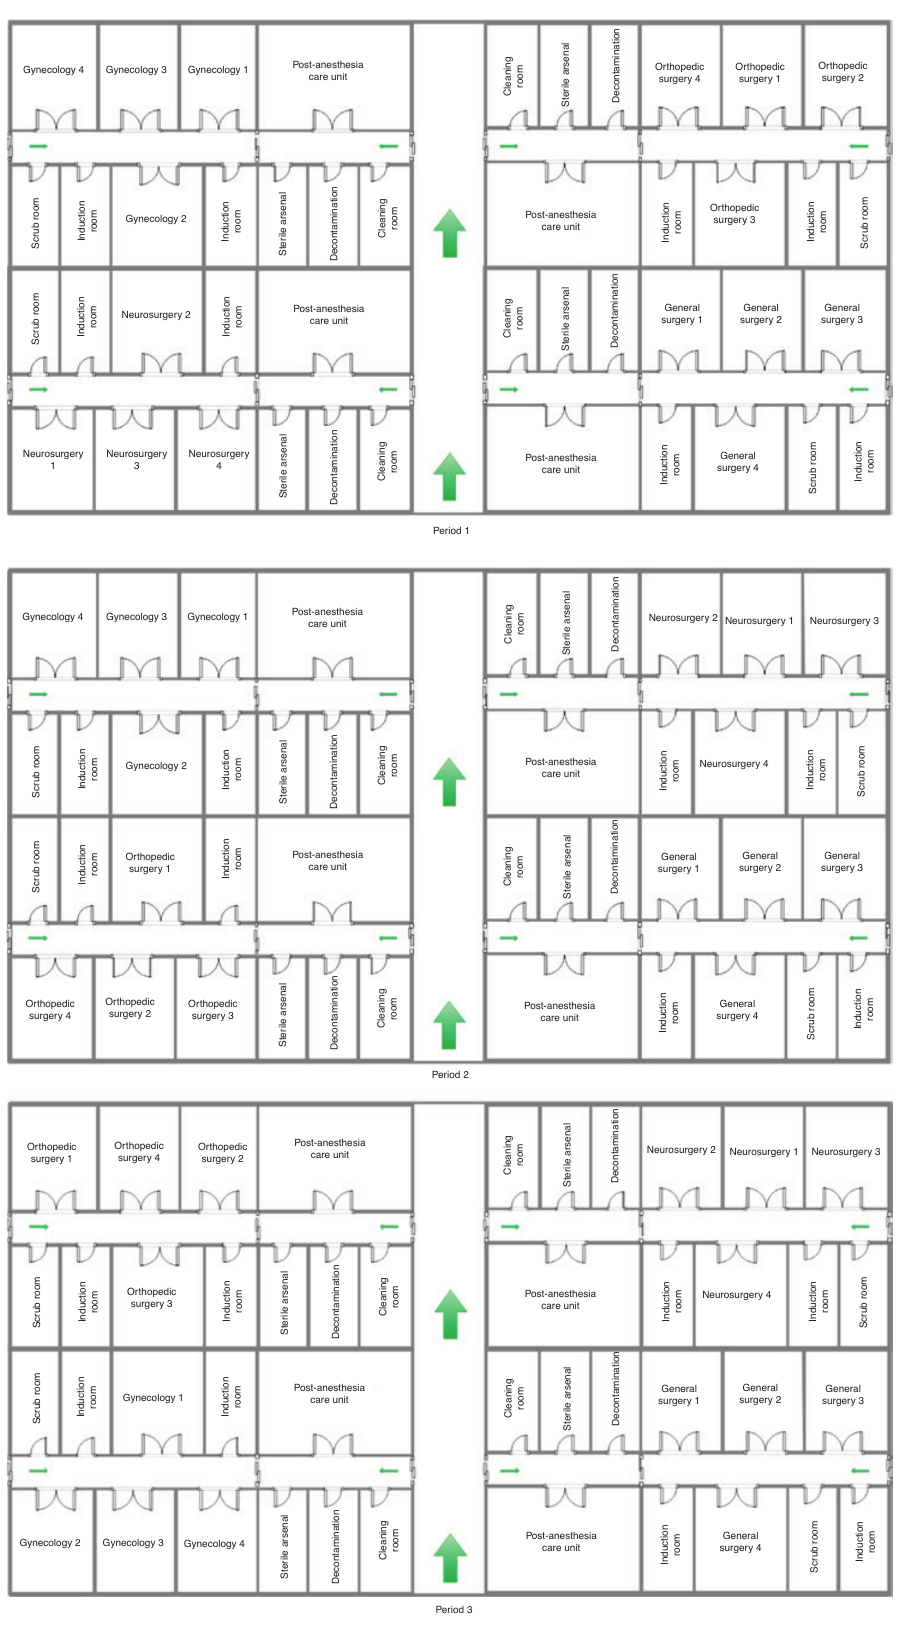
Figure 8: AOTLP: Final OT